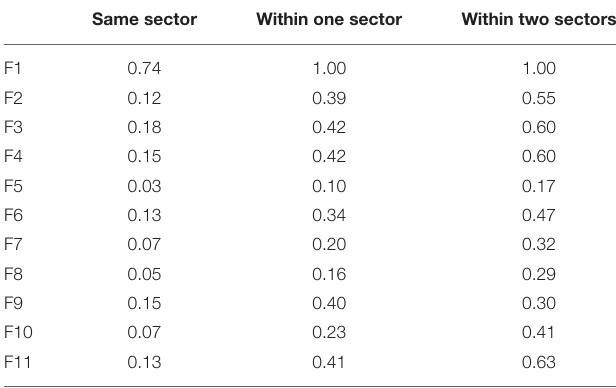
TABLE 5 | Proportional overlap between predictions and observations at 1-min time steps. Same sector Within one sector